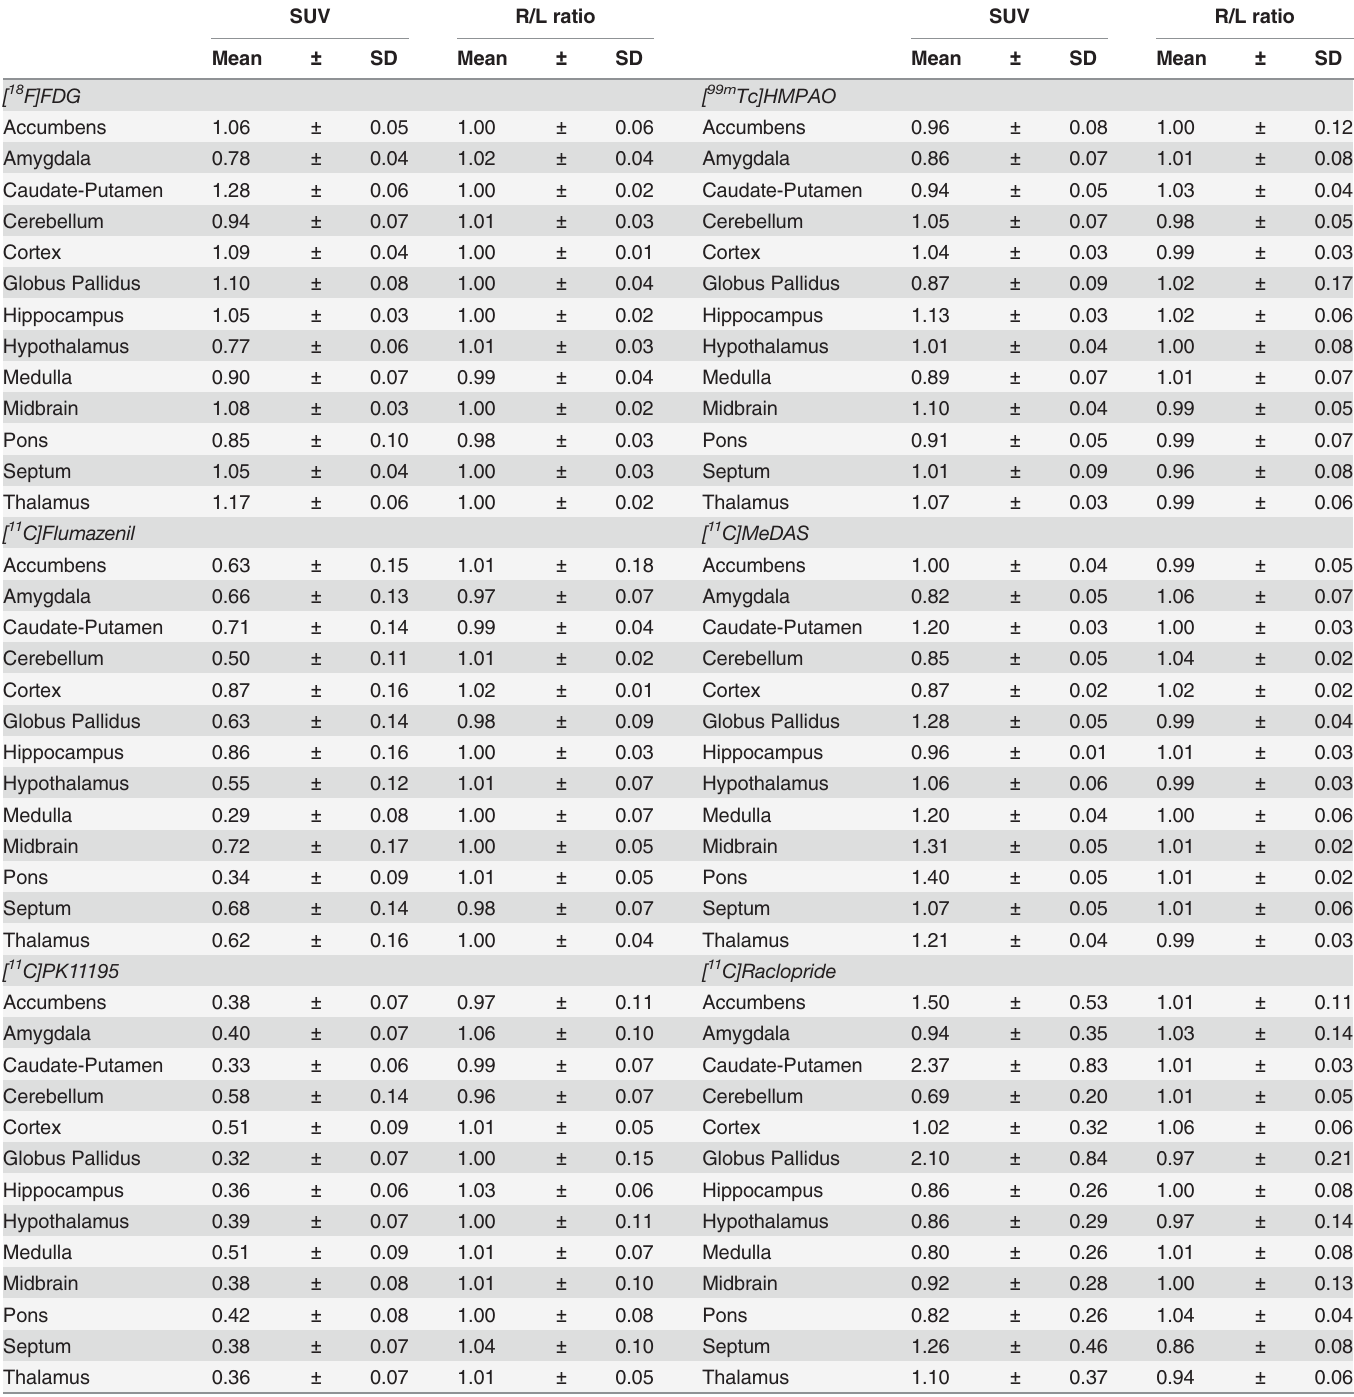
Table 2. Mean SUV uptake, and right/left ratio obtained using VOI